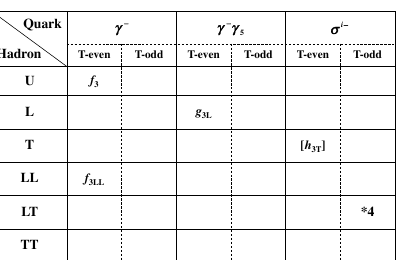
Table 6: Twist-4